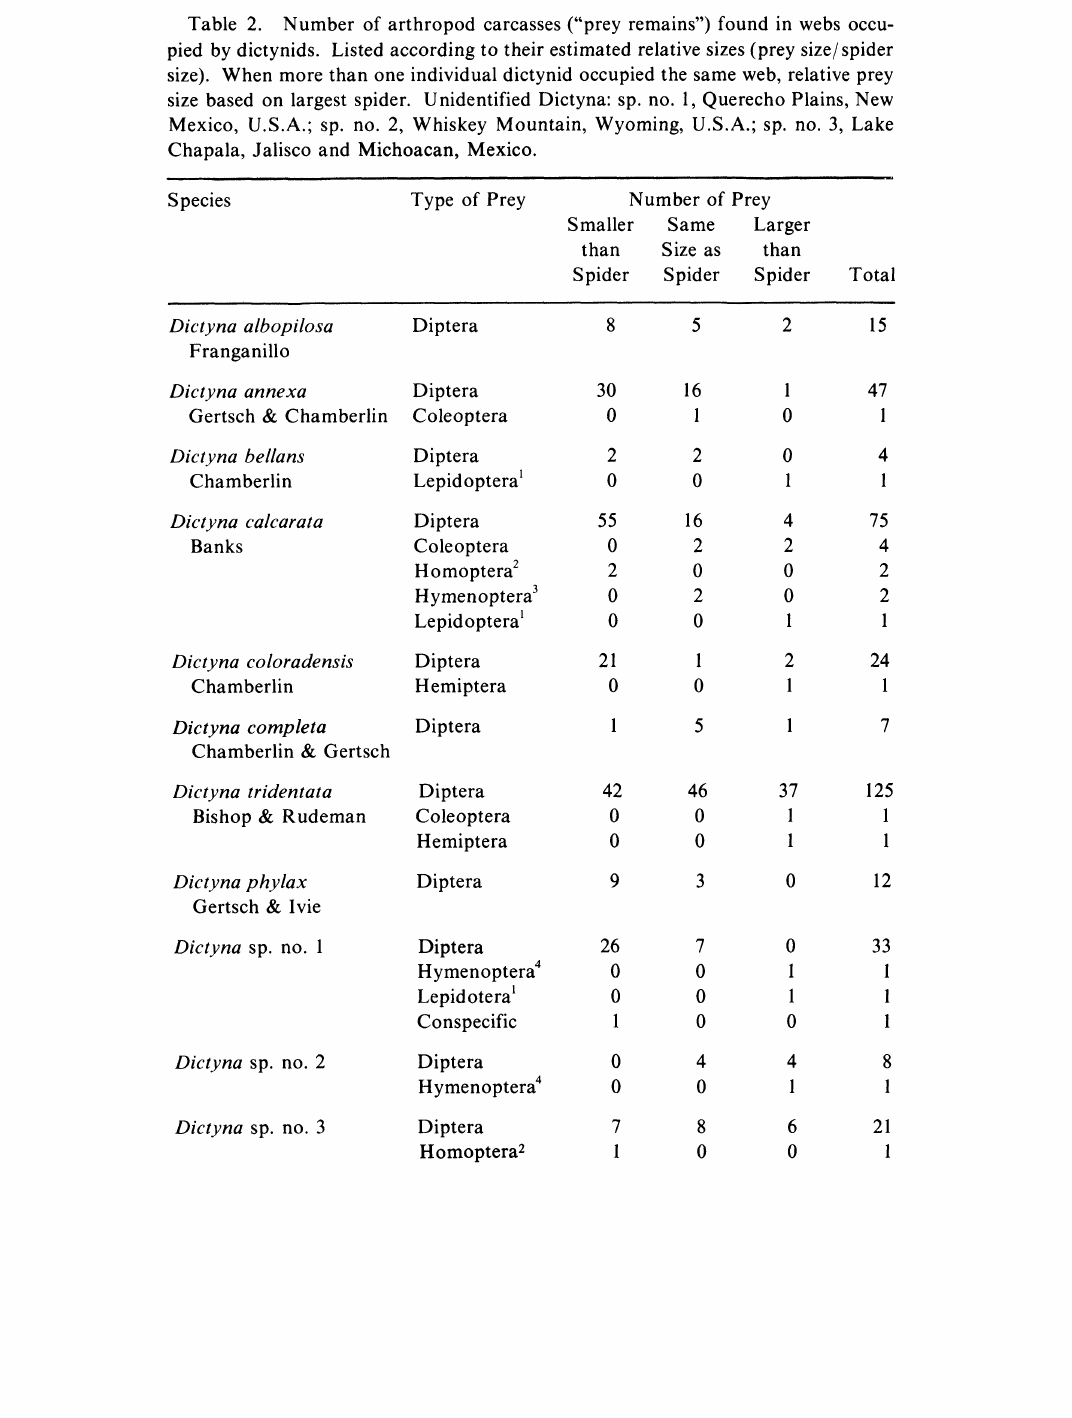
Table 2. Number of arthropod carcasses ("prey remains") found in webs occu- pied by dictynids. Listed according to their estimated relative sizes (prey size/spider size). When more than one individual dictynid occupied the same web, relative prey size based on largest spider. Unidentified Dictyna: sp. no. 1, Querecho Plains,